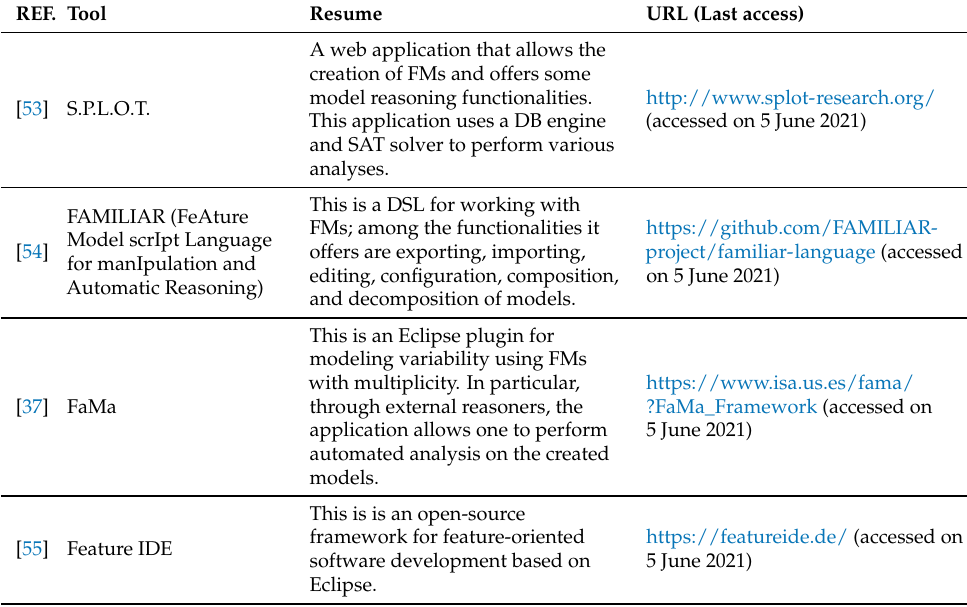
Table A2. List of tools supporting AAFM.